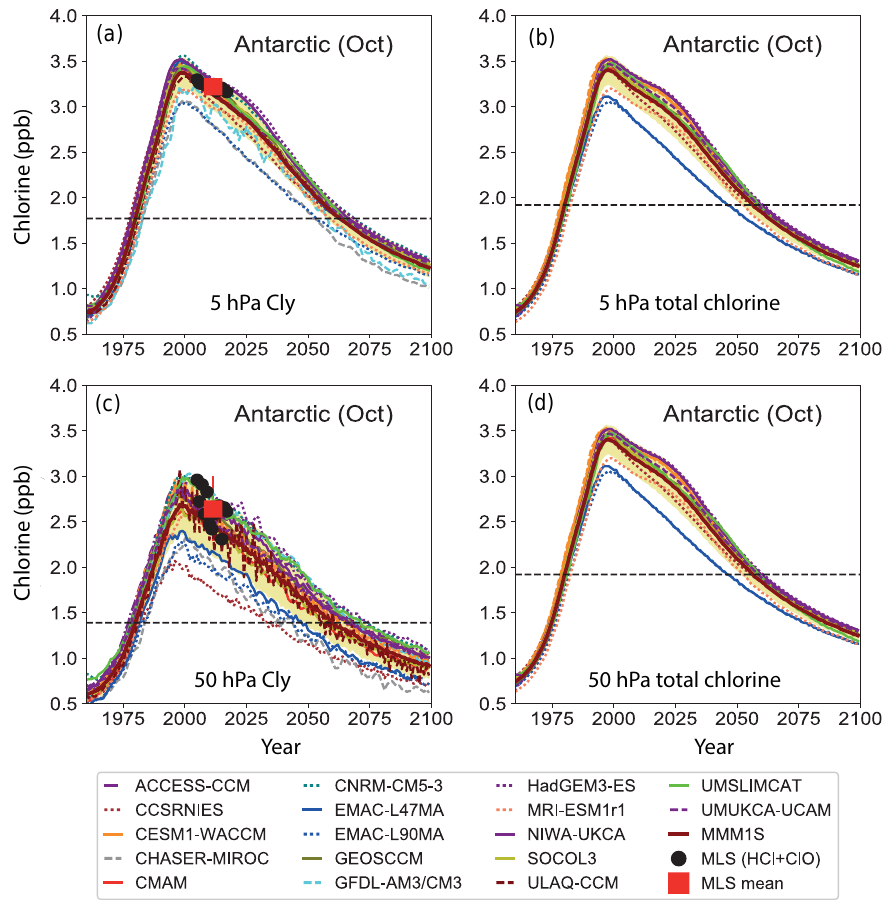
Figure 7. Evolution of (a, c) inorganic chlorine (Cl y , ppb) and (b, d) total (organic + inorganic) chlorine from the REF-C2 simulations for 17 individual models and the MMM1S over the Antarctic in October at (a, b) 5hPa and (c, d) 50hPa. The dashed black lines show the 1980 reference value. Also shown in the left panels are observed October mean values of the sum of HCl and ClO from version 4 of the Microwave Limb Sounder (MLS) data (Waters et al., 2006; Livesey et al., 2018) from 2005 to 2017 (black dots) and the mean value over that period (red square). Note that not all models are plotted in the right-hand